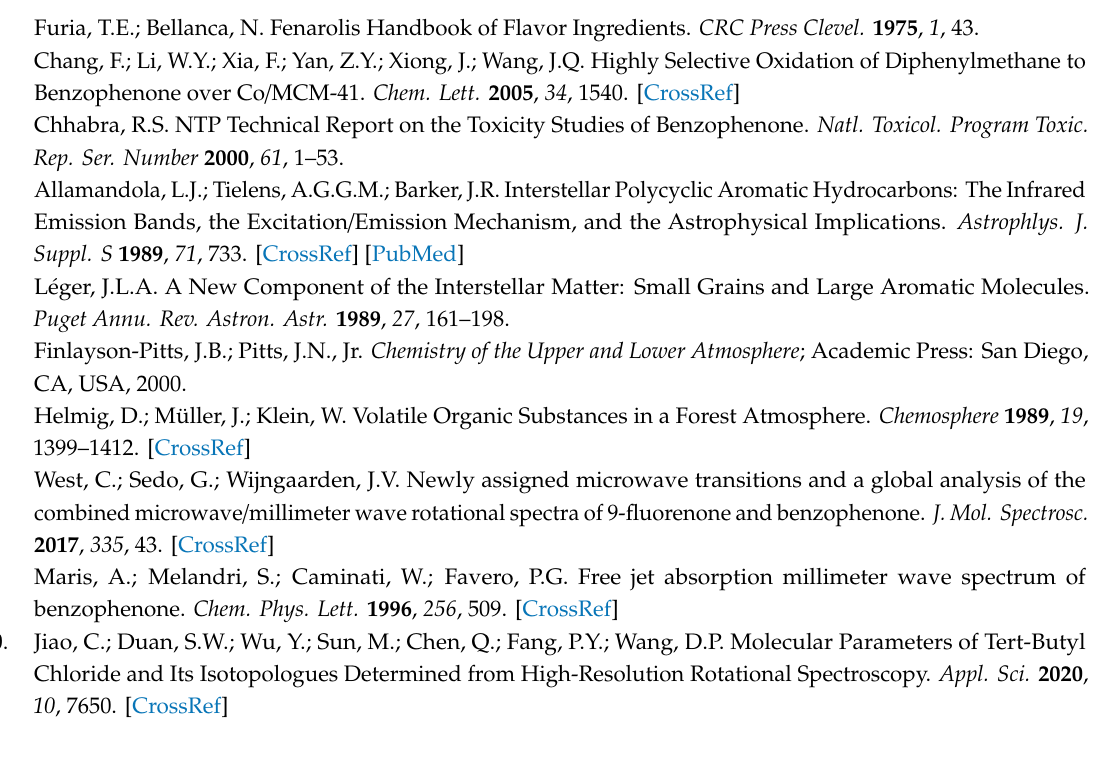
Table S1: X, Y, Z coordinates of the optimized structure using MP2 / cc-pVDZ method; Table S2: X, Y, Z coordinates of the optimized structure using B3LYP / cc-pVDZ method; Table S3: Observed Benzophenone